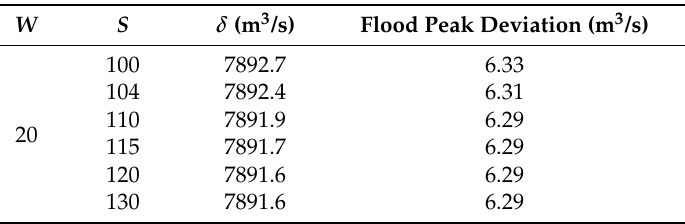
Table 3. Sensitivity analysis of step